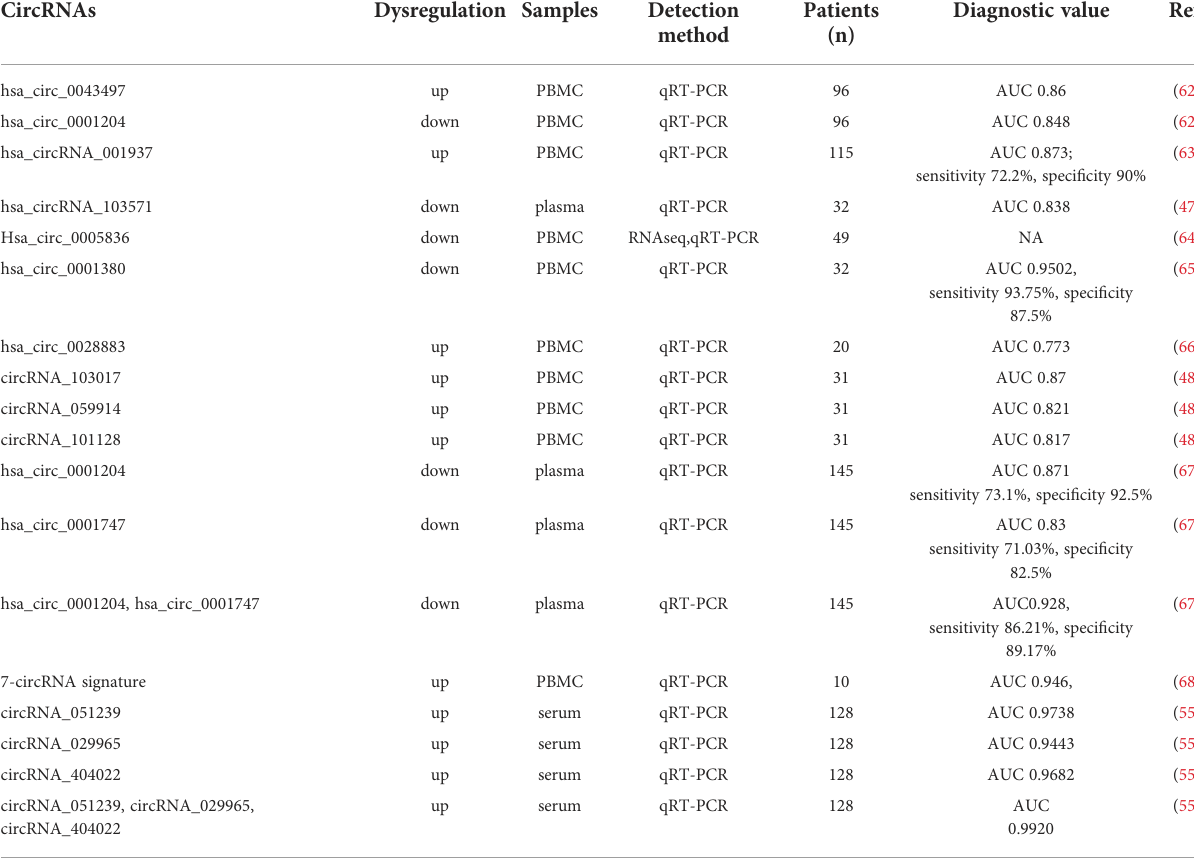
TABLE 1 CircRNAs as tuberculosis diagnostic